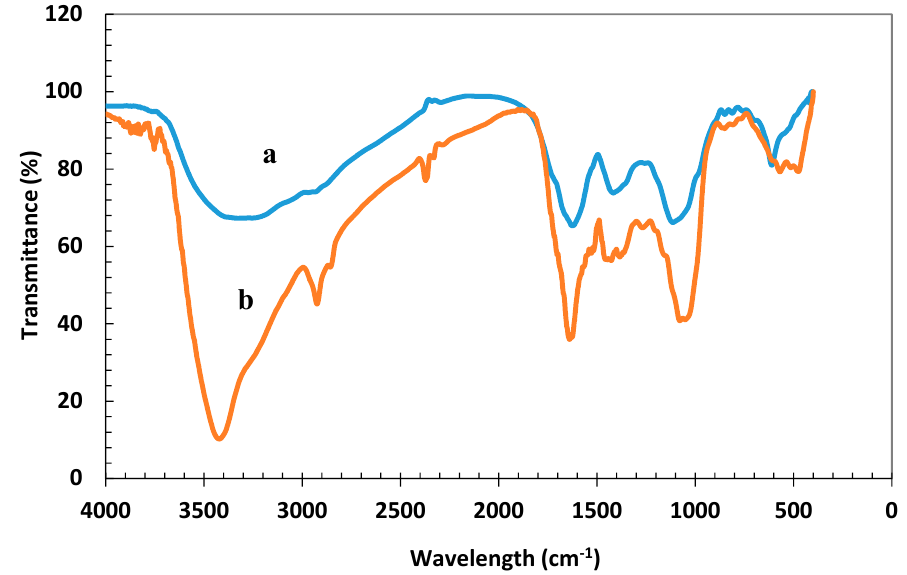
Figure2. Fourier-transforminfraredspectroscopy(FTIR)spectrumofironnanoparticles(NPs)( a ) before Figure 2. Fourier-transform infrared spectroscopy (FTIR) spectrum of iron nanoparticles (NPs) ( a ) and ( b ) after the adsorption process (resolution = 4, scan times = 10). before and ( b ) after the adsorption process (resolution = 4, scan times = 10).